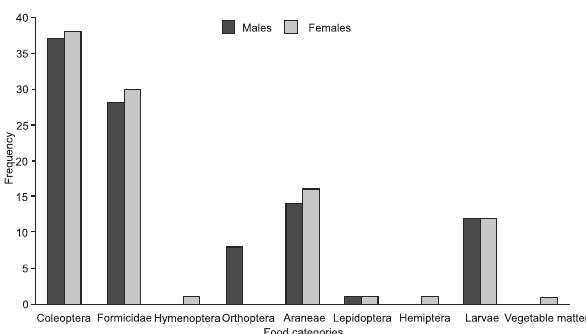
Figure 1. Comparison between sexes of frequency (%) of food cate- gories recorded by stool samples (male = 28, females = 30), stom- ach (male = 1) and direct observations (male = 67, females = 68).